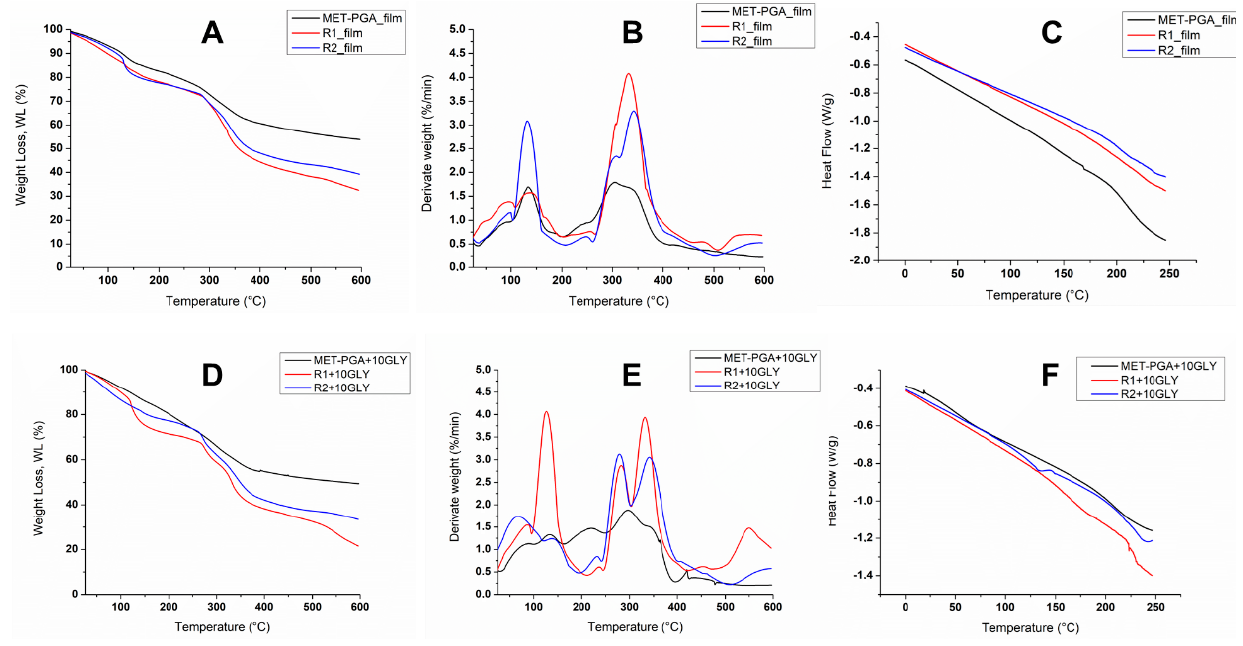
Figure 6. Thermogravimetric ( A , D ), differential thermogravimetric ( B , E ) and differential scanning calorimetric (second heating ramp) ( C , F ) thermograms of MET-PGA, R1 γ -PGA and R2 γ -PGA films, without ( A – C ) and with ( D – F ) 10% glycerol (10GLY).